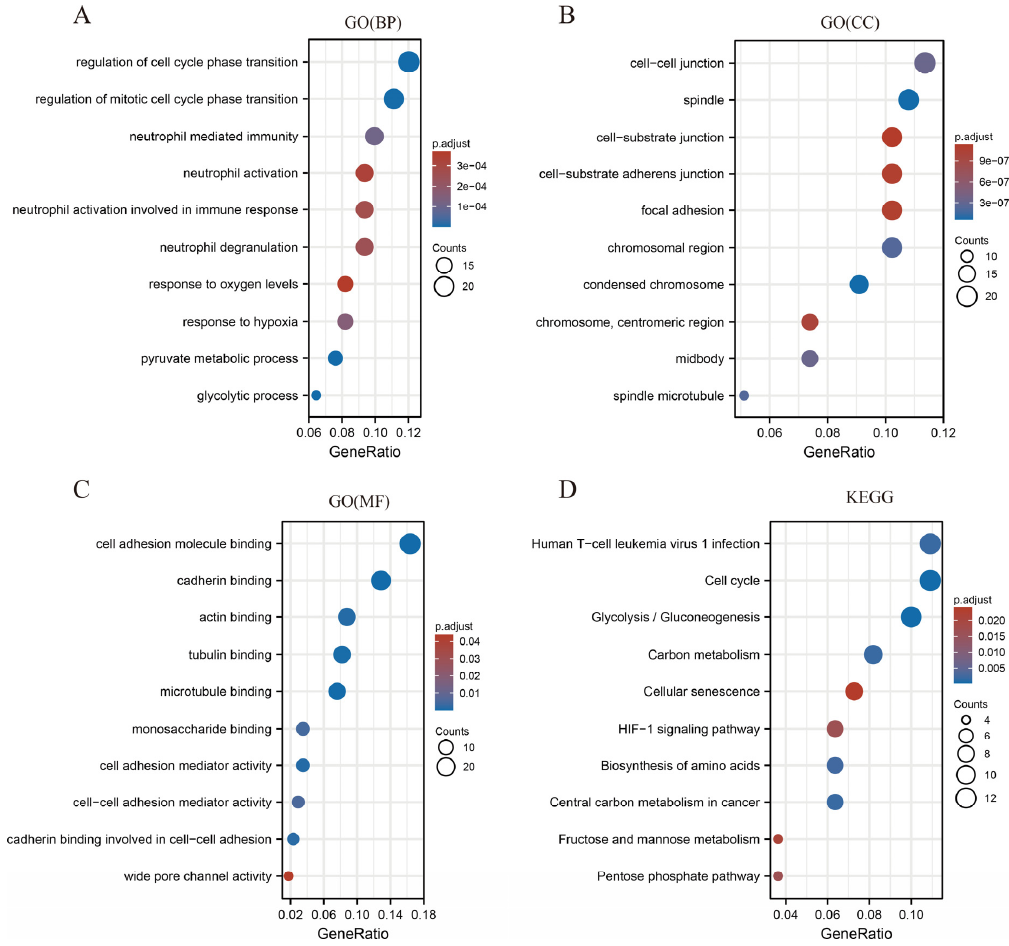
Figure 11. GO ( A – C ) and KEGG ( D ) functional enrichment analyses of SLC2A1-related DEGs in TCGA LUAD .